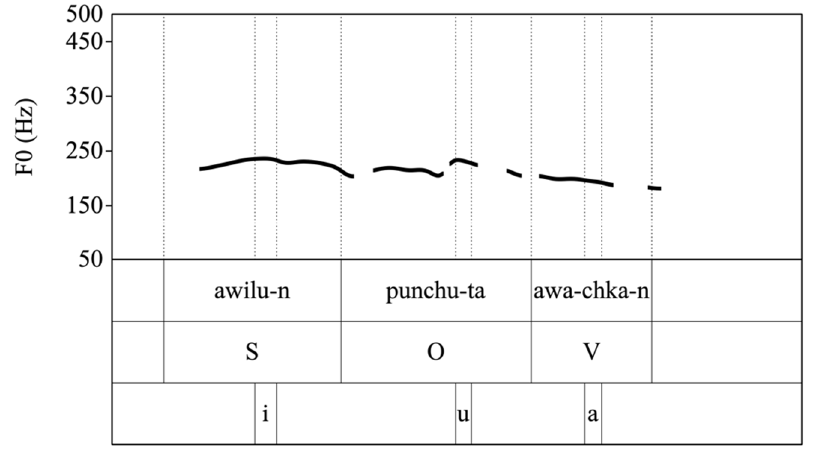
Figure 3. Intonational contour corresponding to example (16), as produced by a female speaker of Cusco Quechua.